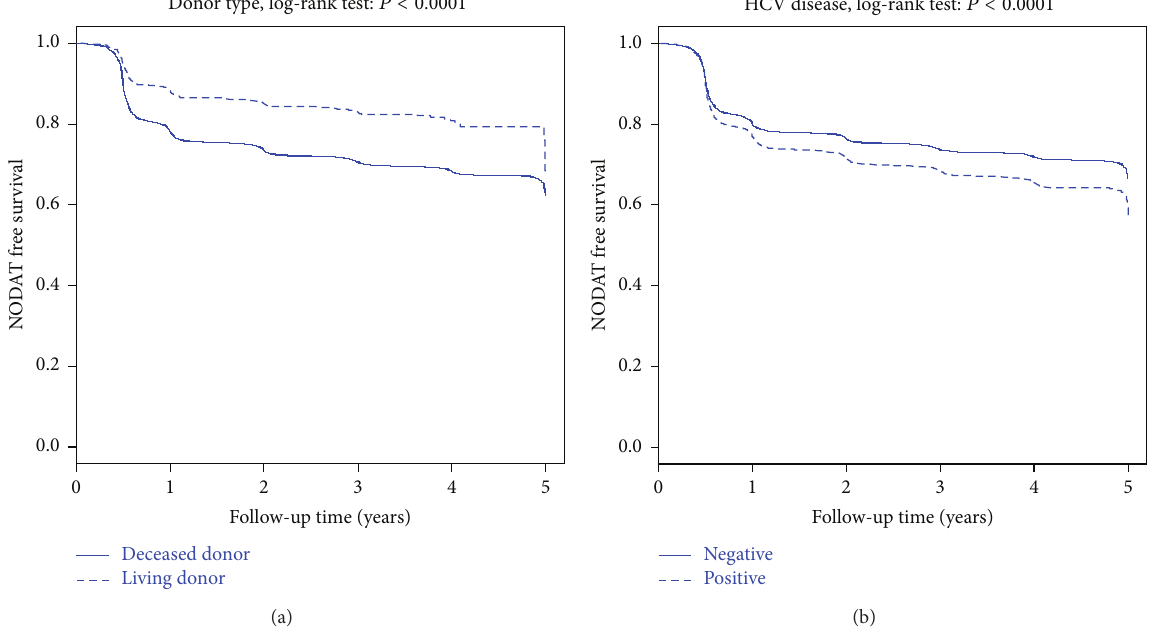
Figure 2: Kaplan-Meier NODAT-free survival curves for LDLT and DDLT recipients according to donor type and